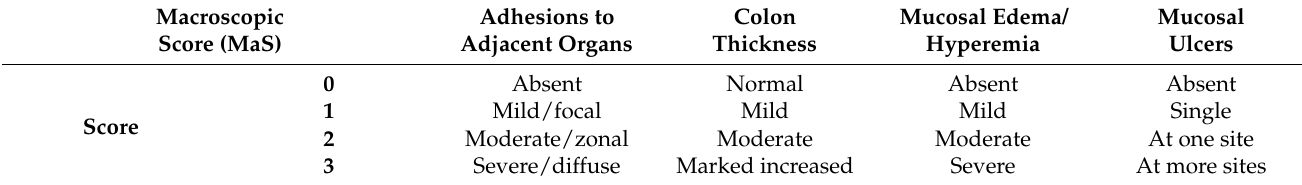
Table 2. Macroscopic score